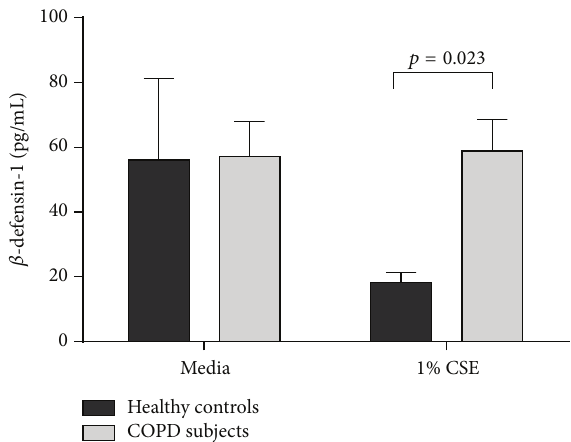
Figure 6: Production of 𝛽 -defensin-1 from pBECs in response to cigarette smoke extract. The level of 𝛽 -defensin-1 release is lowered in response to cigarette smoke in healthy pBECs ( 𝑛 = 4 ) but retained in pBECs from subjects with COPD ( 𝑛 = 10